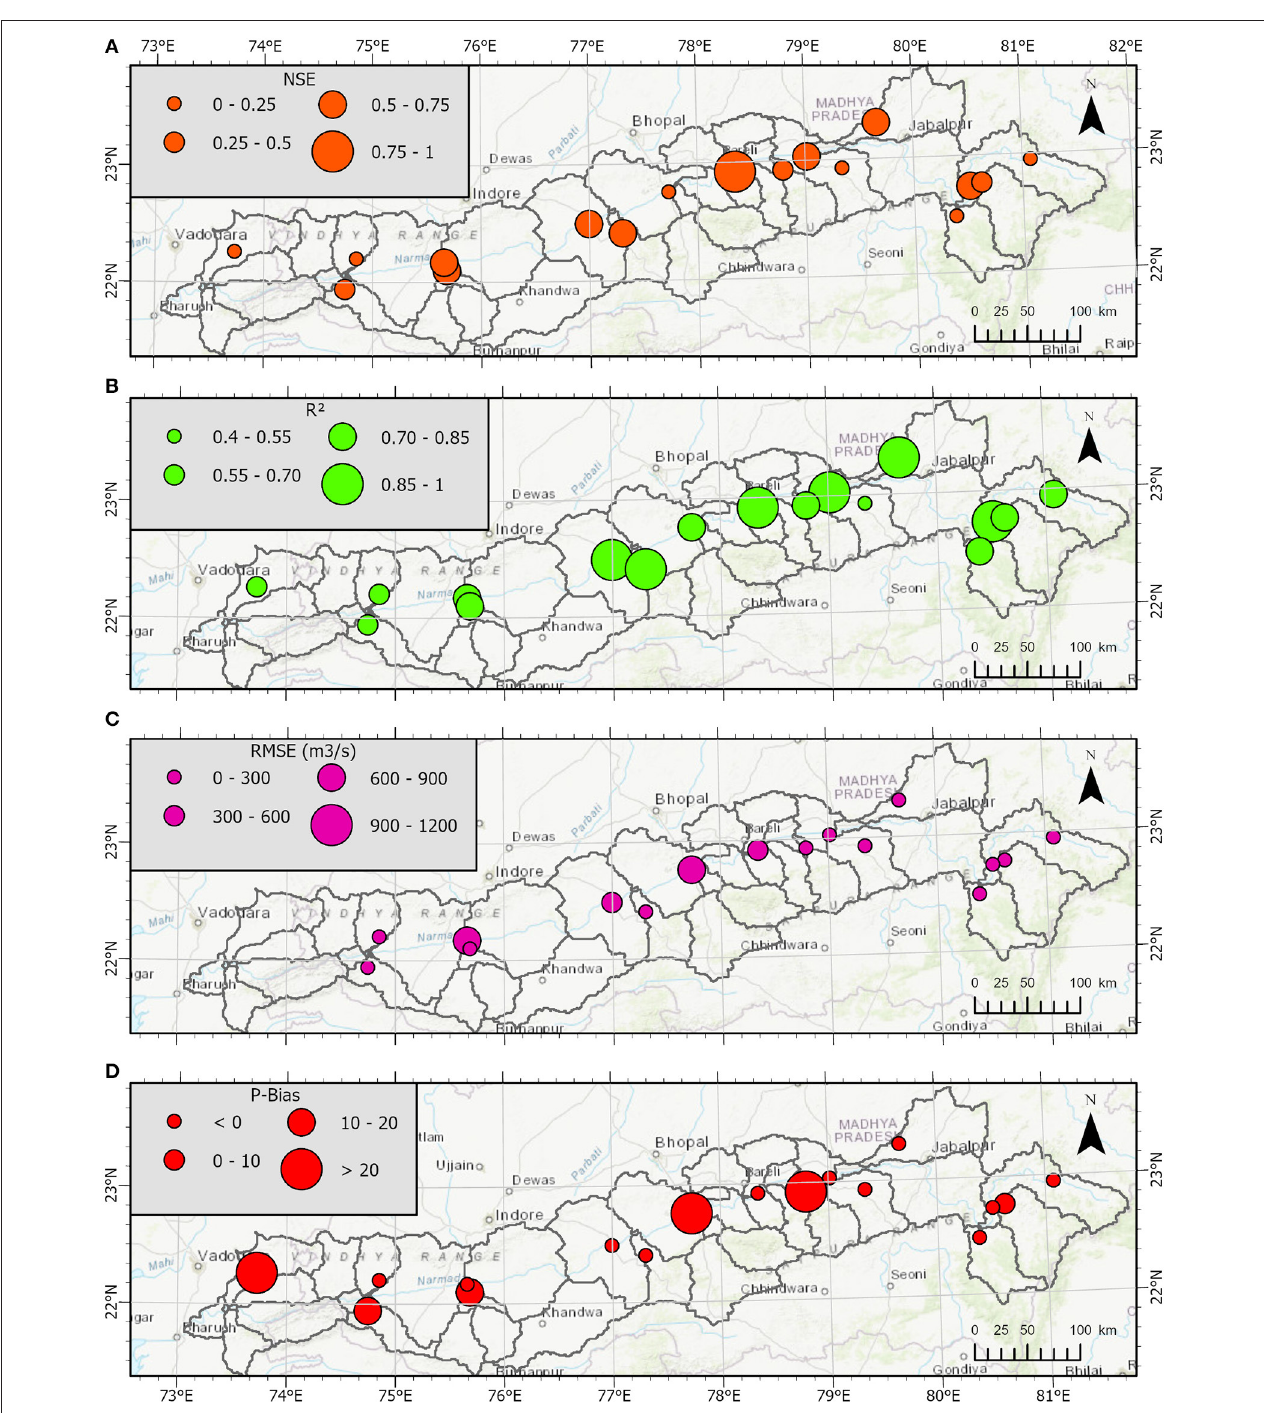
FIGURE 4 | (A–D) : SWAT model performance statistics for streamflow simulation. (A) Nash-Sutcliffe efficiency, (B) Correlation coefficient squared, (C) Root mean squared error, and (D) Percent bias, for 17 gauge locations inside the Narmada River basin.